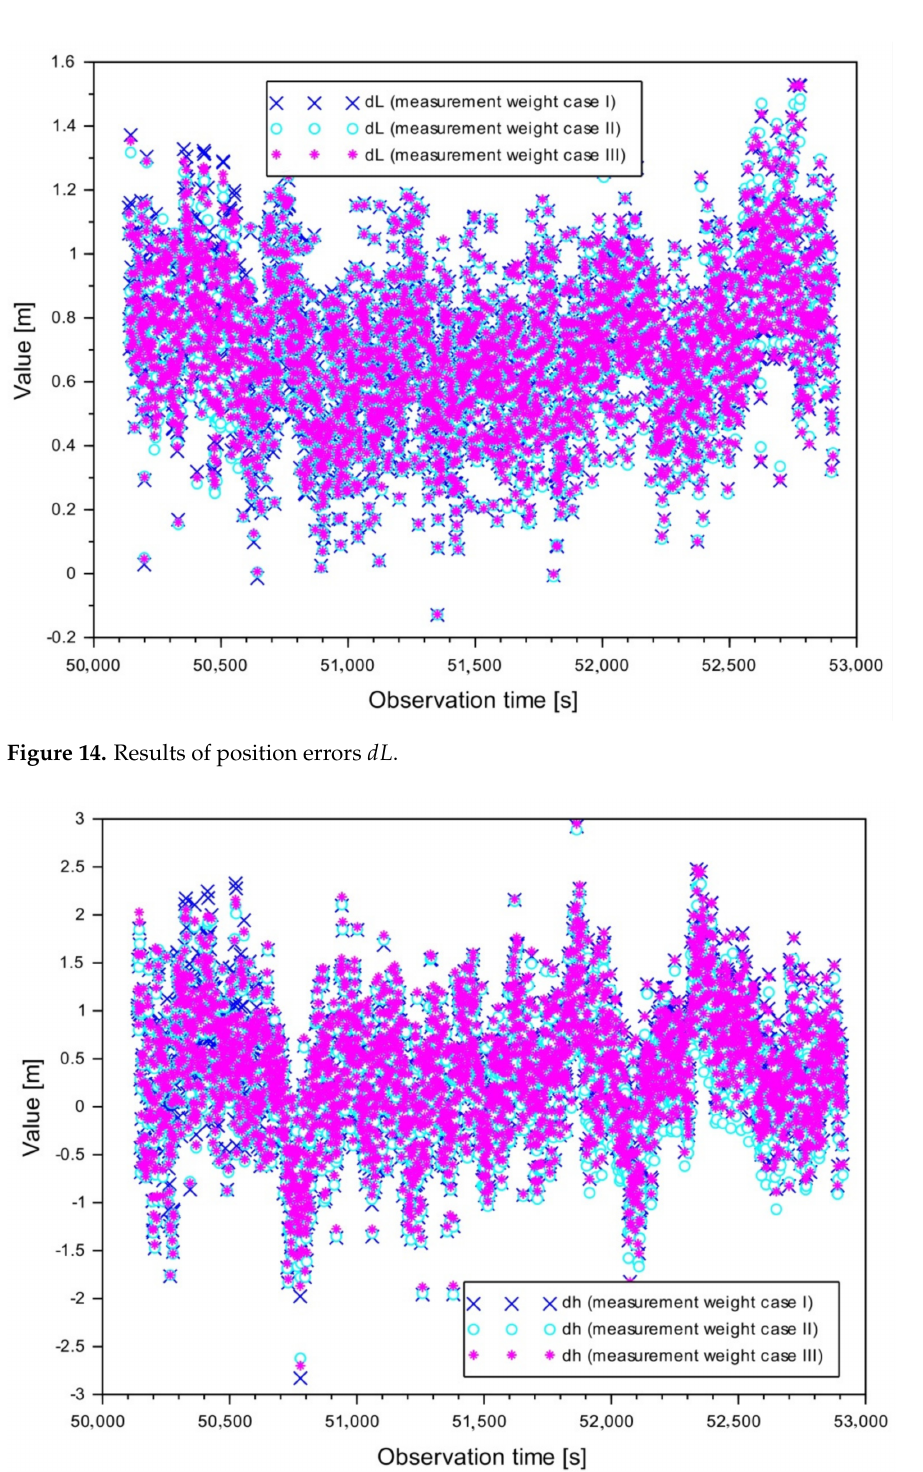
Figure 15. Results of position errors dh